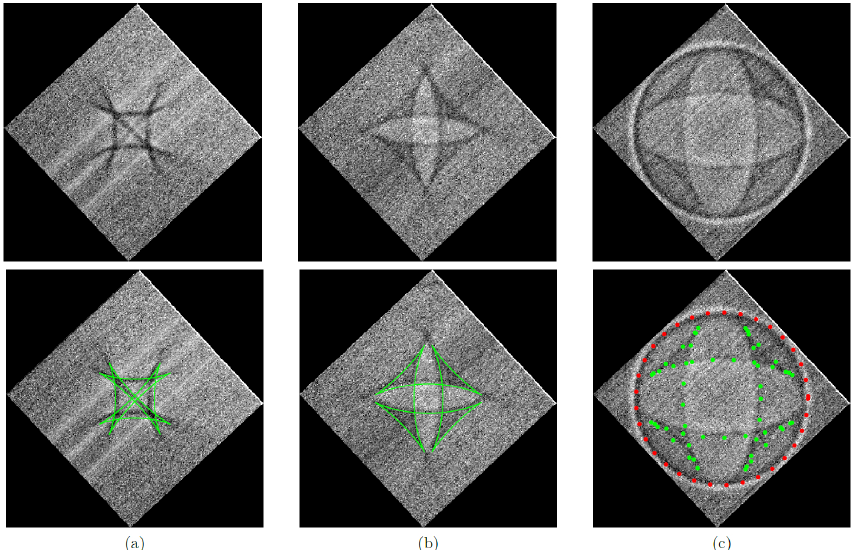
Figure 8. Top panel: Experimental phonon imaging pattern (100 × 100 µ m 2 ) in the (100) plane of silicon at three different delay times: ( a ) 8.3 ns, ( b ) 9.6 ns, and ( c ) 10.7 ns. Lower panel: Comparison between simulation and experimental phonon imaging patterns using C 11 = 165.7 GPa, C 12 = 63.9 GPa, and C 44 = 79.5